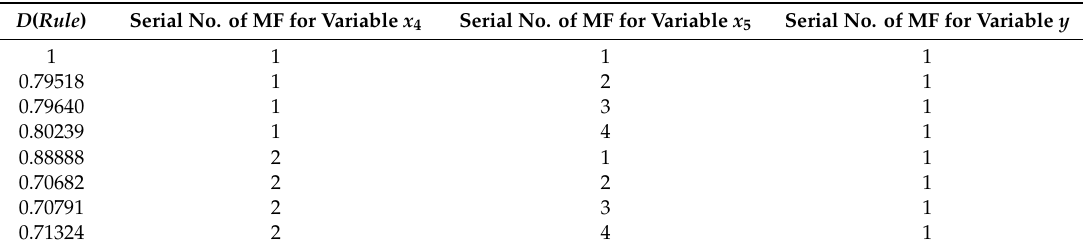
Table 4. The fuzzy rules obtained from the empirical data in the case of space capabilities